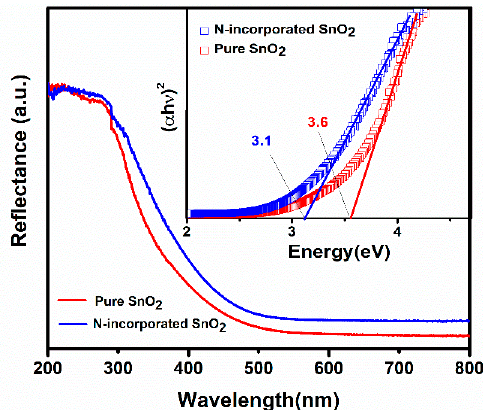
Figure 9. Optical diffuse reflectance spectra of the N-incorporated SnO 2 and pure SnO 2 samples. The inset shows the energy dependence of ( α h ν ) 2 for the samples.